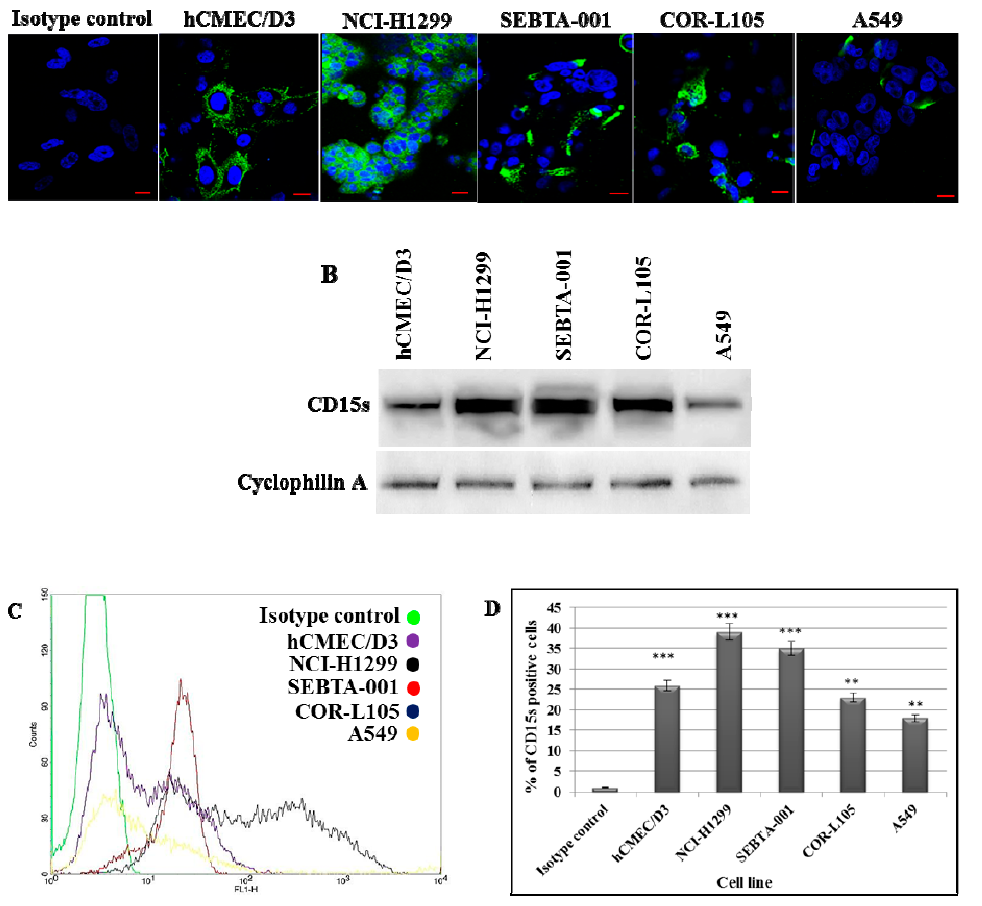
Figure 1. Expression of CD15s in brain endothelial and lung cancer cell lines: ( A ) Representative ICC images showing CD15s in hCMEC/D3, NCI-H1299, SEBTA-001, A549 and COR-L105. Hoechst blue was used as a nuclear counterstain. Scale bar = 20 µm; ( B ) Western blot analysis of CD15s of proteins from the cell lines showed highest CD15s expression in NCI-H1299 and SEBTA-001 followed by hCMEC/D3, COR-L105 and A549. Cyclophilin A was used as a protein loading control; ( C ) representative flow cytometric histograms (Green: control, purple: hCMEC/D3, black: NCI-H1299, red: SEBTA-001, blue COR-L105 and yellow: A549); ( D ) quantitative flow cytometric analysis of CD15s expression on hCMEC/D3, NCI-H1299, SEBTA-001, COR-L105 and A549. CD15s was overexpressed in NCI-H1299 and SEBTA-001 with less expression in hCMEC/D3, COR-L105 and A549. n = 3, *** p < 0.001 and ** p < 0.01. Data is expressed as ±SE.